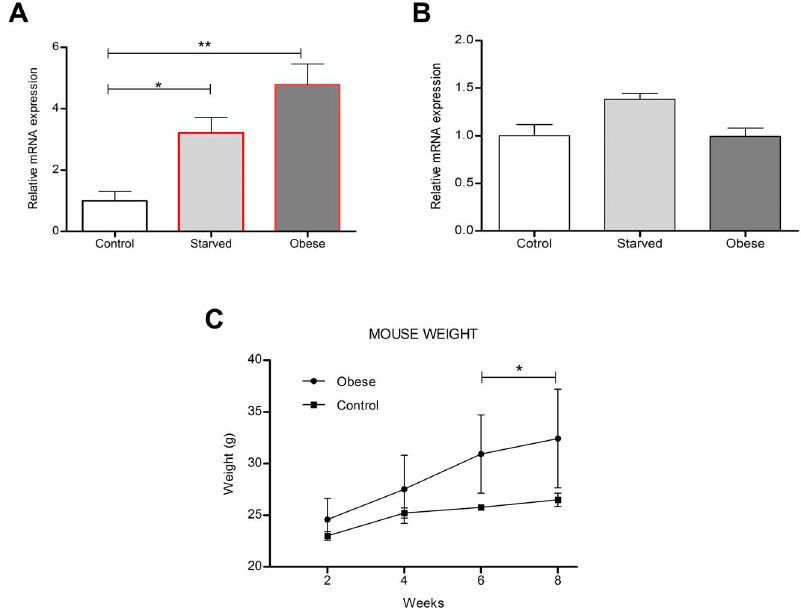
Figure 8. Diet regulates mouse hypothalamic Tfap2b and Kctd15 transcript levels. (A,B) Relative level of (A) Tfap2B and (B) Kctd15 expression in the hypothalamus from starved or obese male mice (n=10 qPCR runs; one-way ANOVA with Bonferroni post hoc test for multiple comparisons, * P , 0.05, ** P , 0.005). (C) Mice were either fed a normal or high fat diet for 8 weeks. By week six mice raised on a high fat diet were significantly higher in weight than control mice (Two-way ANOVA with P , 0.05 was calculated to ensure that the obese mice were significantly heavier than the controls). Error bars represent SD.